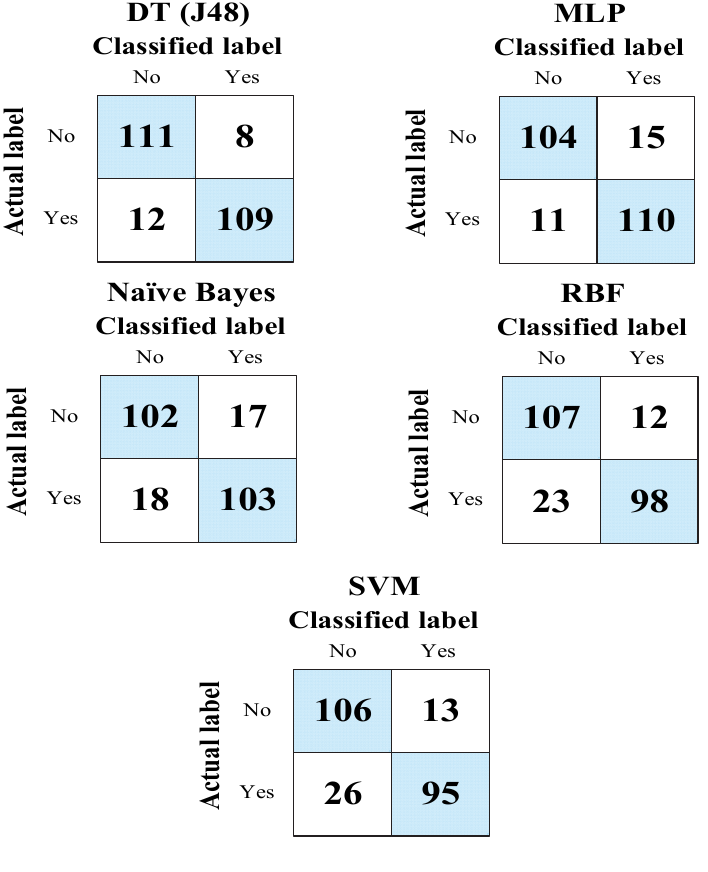
Fig. 4. Obtained confusion